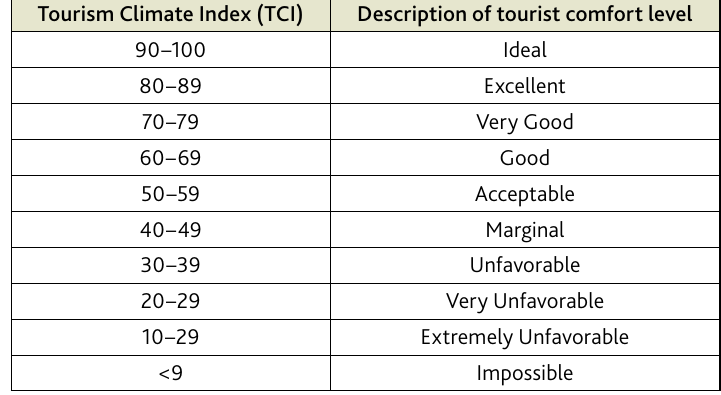
Table 2. Classification scheme for the